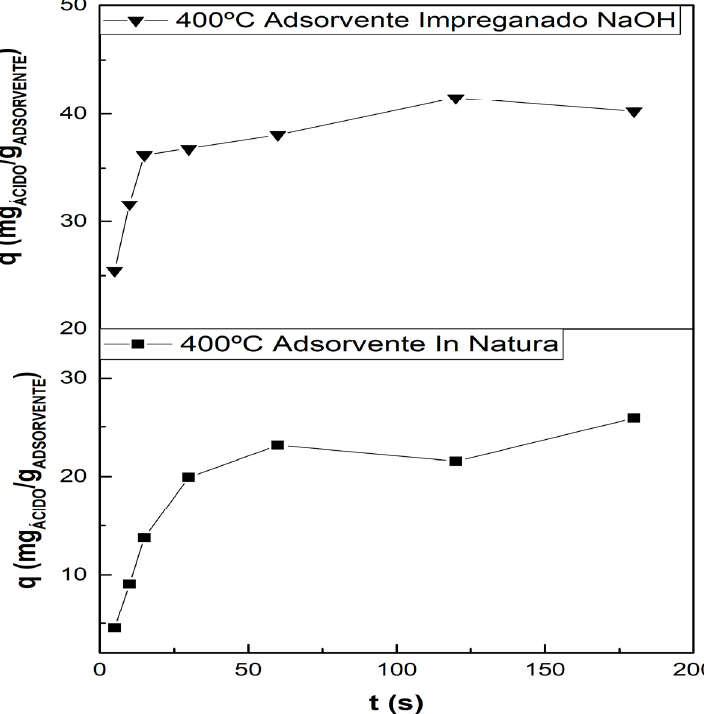
Figure 8. Equilibrium Time Chart of the kinetic assay of açaí seed in nature and impregnated at a temperature of 400 °C.